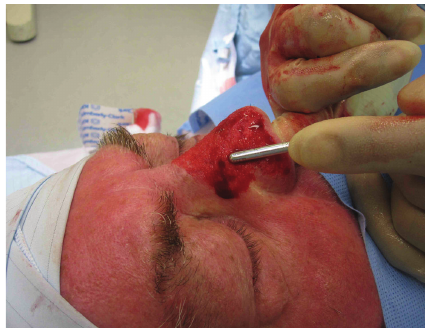
Figure 1: Case 3, technique with bimanual approach to enable maximal tactile feedback, note the microdebrider is held like a pen.